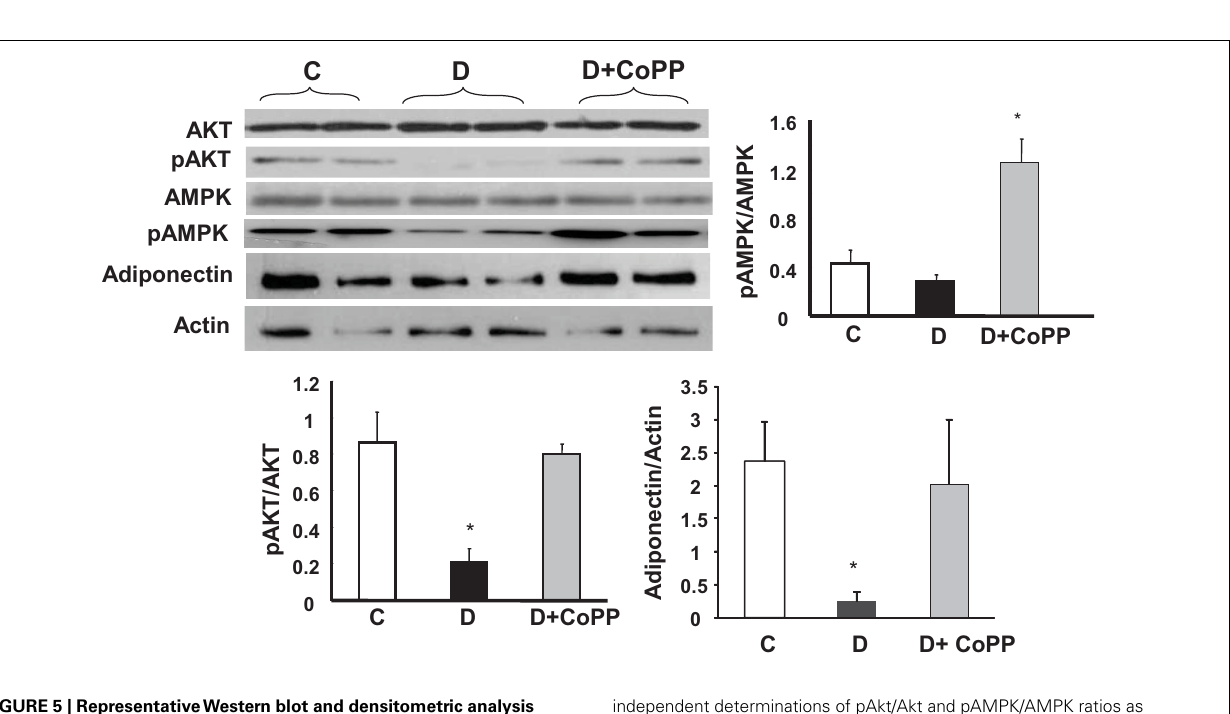
FIGURE 4 | RepresentativeWestern blot and densitometric analysis of eNOS, p-eNOS, iNOS, from C, D, and D+CoPP rat hearts. Quantitative densitometry evaluation of iNOS and p-eNOS/eNOS ratio